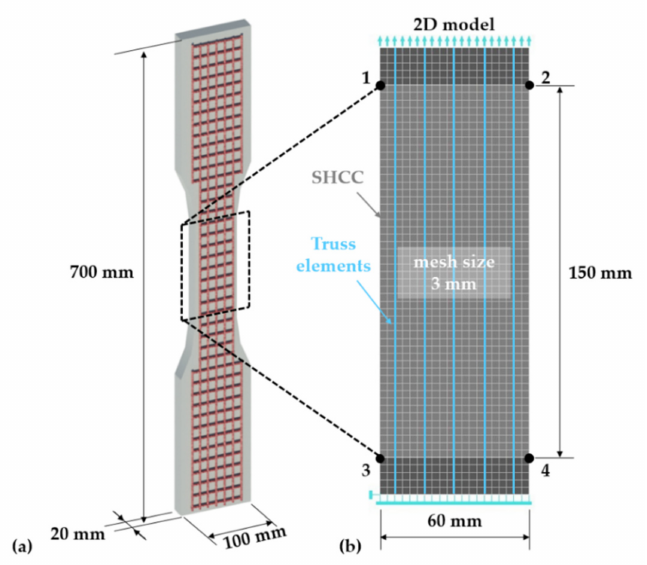
Figure 1. ( a ) Geometry and dimensions of the composite specimens with one layer of textile re- inforcement and ( b ) mesh size and boundary conditions of the modeled region of interest in the 2D